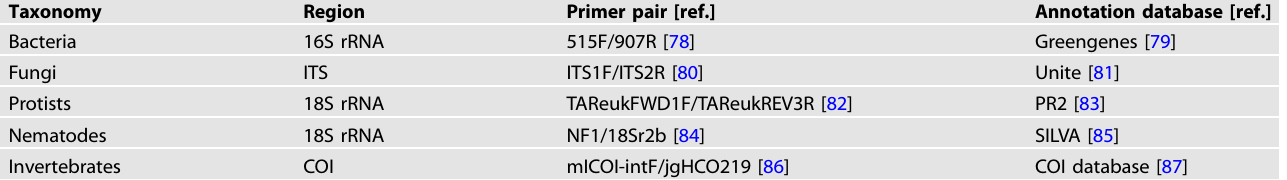
Table 1. Differentiating soil biota into fi ve taxonomic groups based on the sequencing of speci fi c gene targets and associated annotation database. Taxonomy Region Primer pair